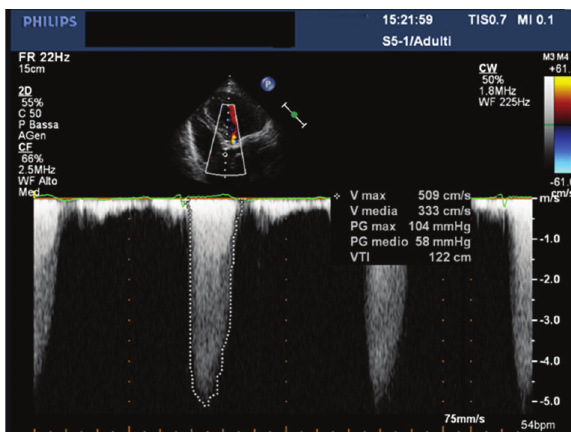
Figure 3: Aortic